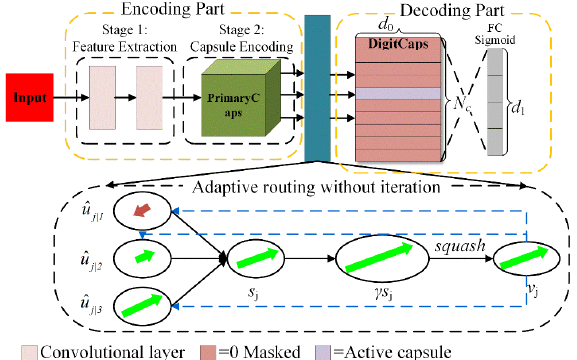
Figure 5. The architecture of PAR-ACaps and the adaptive routing process. Encoding part consists of feature extraction and capsule encoding stages. Decoder part includes DigitCaps layer and dense layers which reconstruct an image from DigitCaps layer representation. FC denotes the fully con- nected layer. 𝑑 (cid:2868) is the dimension of the digital capsule. 𝑁 (cid:3030) is the number of classes. 𝑑 (cid:2869) denotes the dimension of the output of dense layers. Sigmoid represent the activation functions of sigmoid function in FC